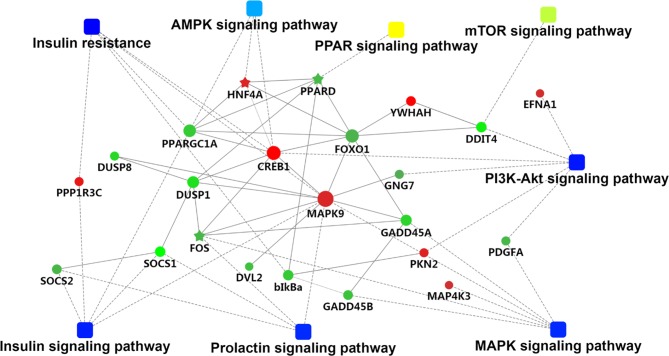
The metabolic network comprising candidate genes in protein–protein interactions (PPI) network and pathways with transcriptomic analyses. The round nodes indicate genes, red indicates up-regulation, and green indicates down-regulation. The rectangular node represents the KEGG pathway/biological process, and the significant p value is represented by yellow-blue gradient; yellow indicates a small p value, while blue indicates a large p value.